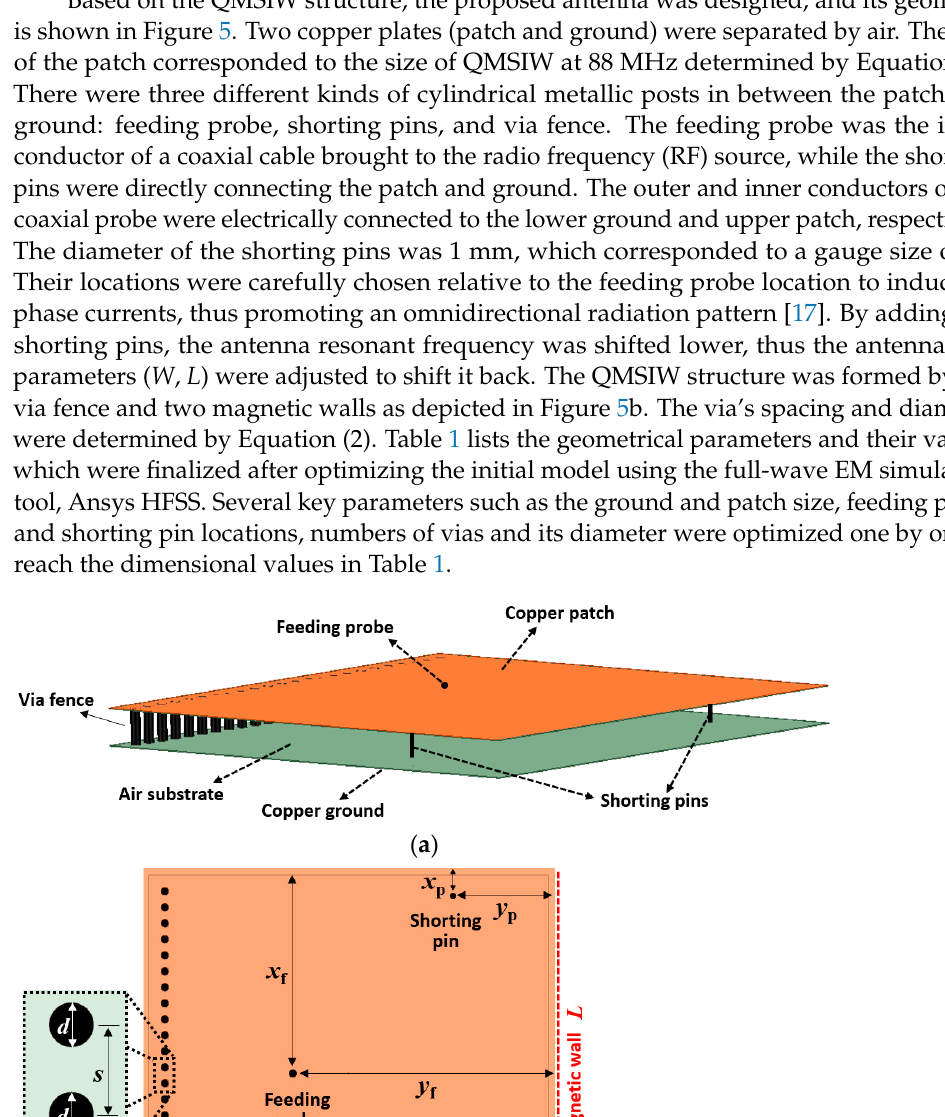
Figure 4. E-field amplitude plots of ( a ) a full-section of SIW, ( b ) a half-section cut in the transverse symmetric axis, and ( c ) a quarter-section cut in the longitudinal symmetric axis.